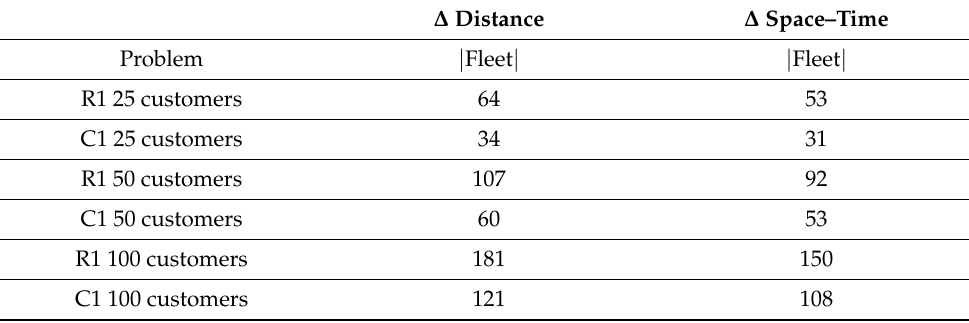
Table 2. Results summary (criterion: fleet